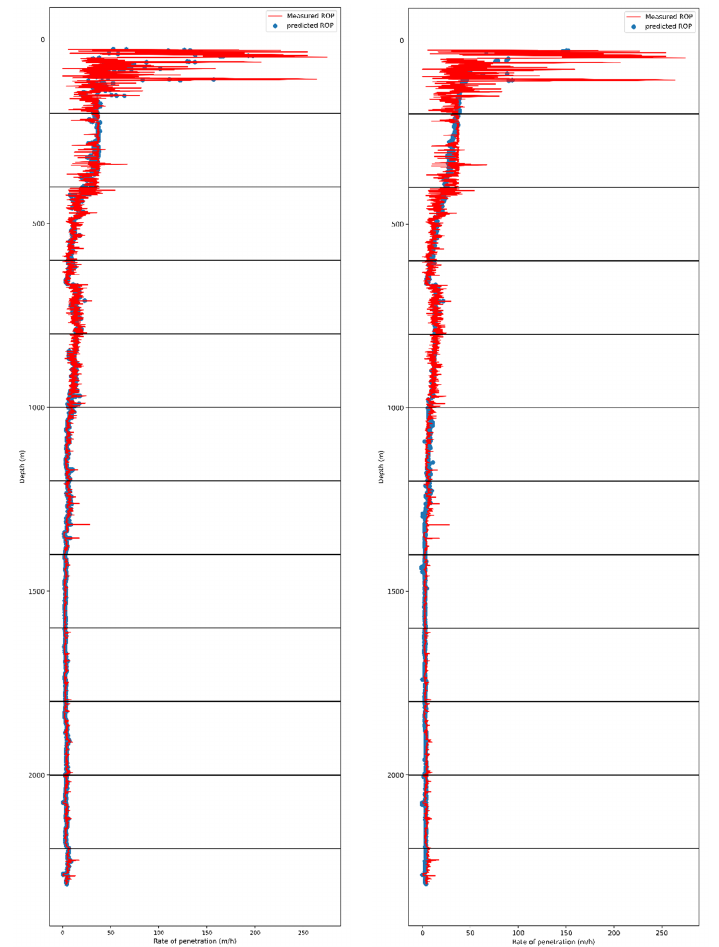
Figure 18. Depth vs ROP profile. ( Left ): random forest prediction. ( Right ): ANN prediction .